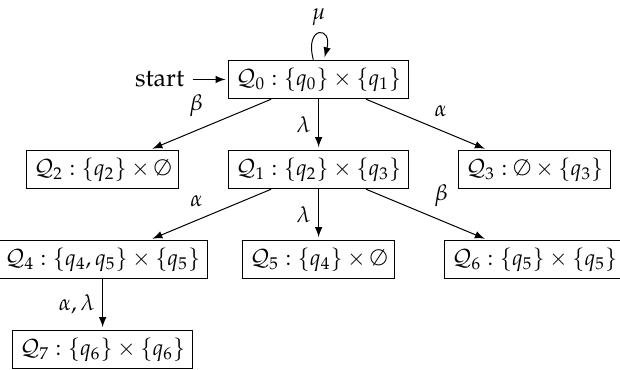
Figure 6. A probabilistic automaton structure G (cid:48)(cid:48) s .